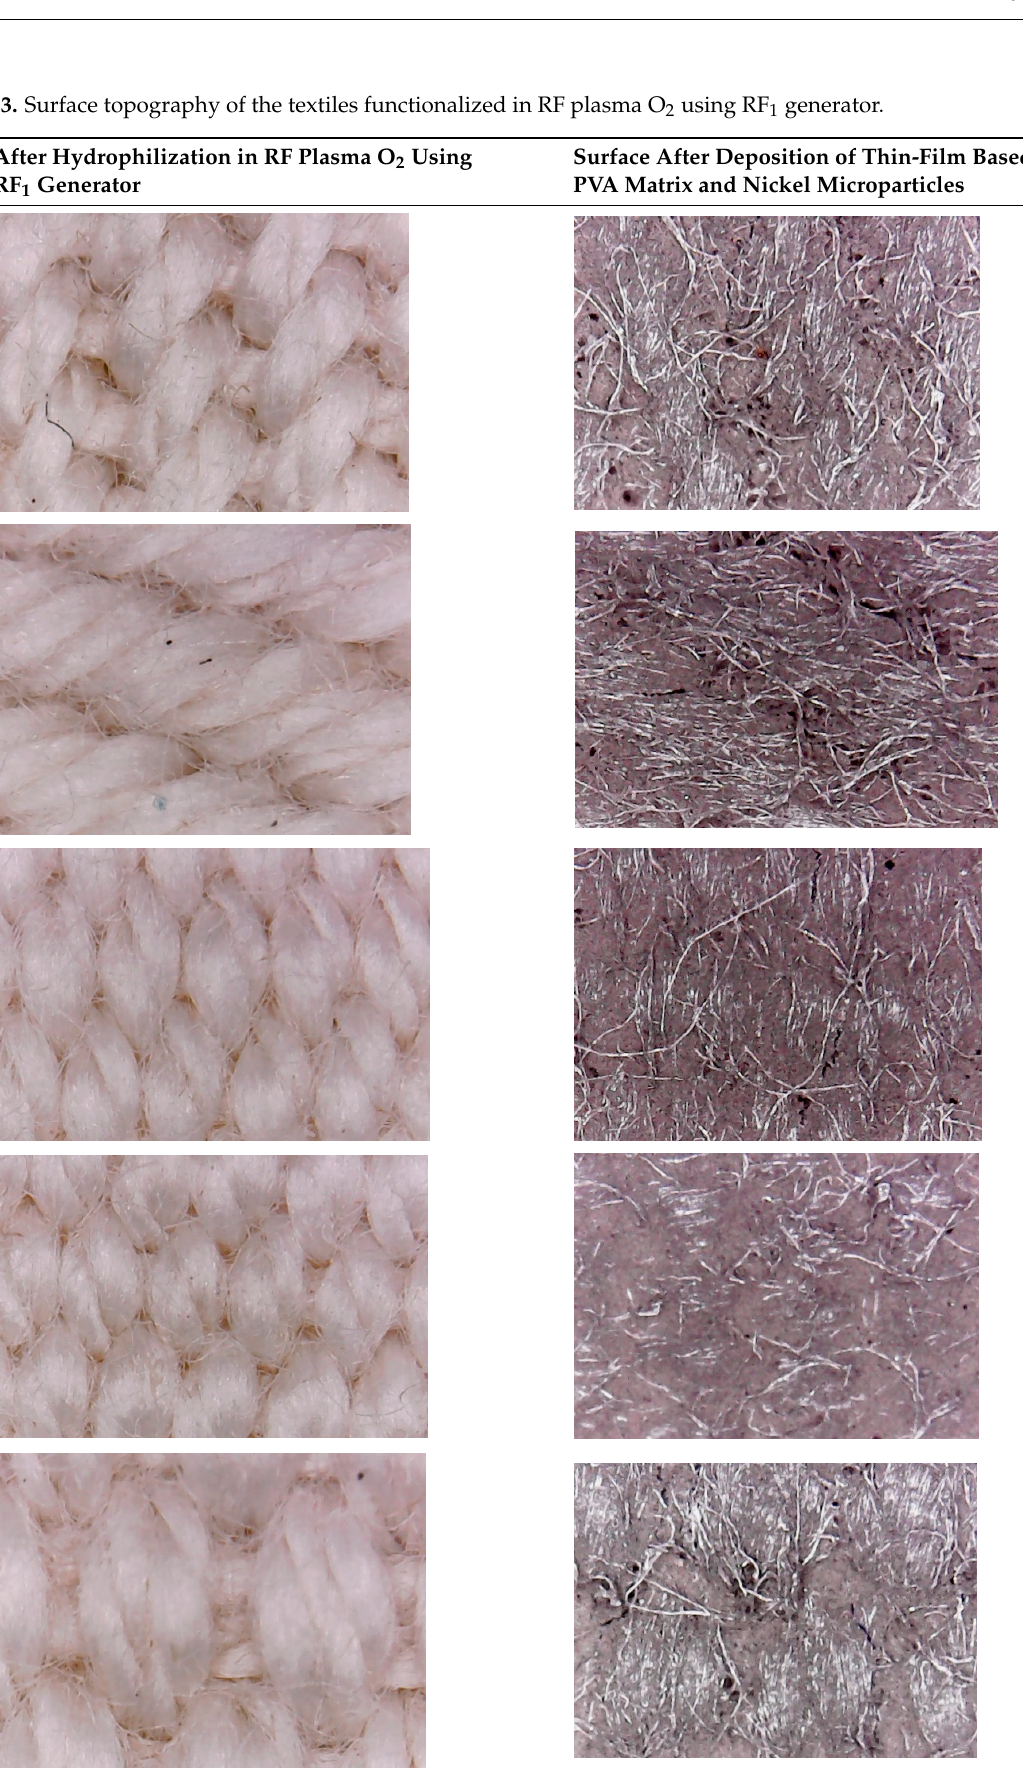
2 using RF 1 generator. Table 3. Surface topography of the textiles functionalized in RF plasma O